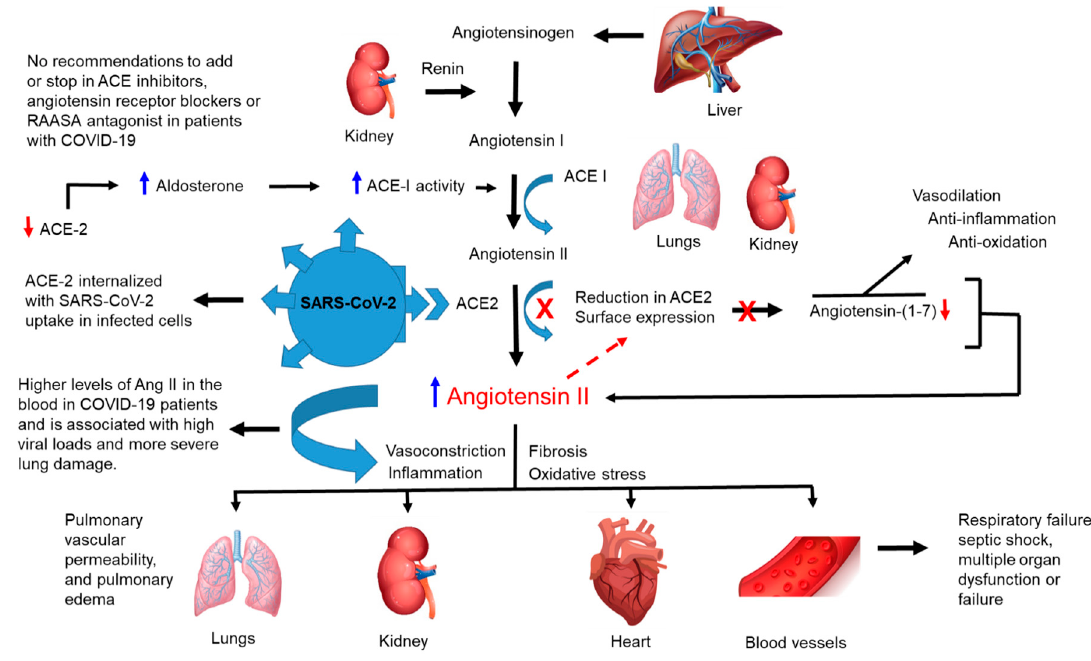
Figure 2. Hypertension and increased risk for severe COVID-19 disease. Hypothetical model of uncontrolled blood pressure in patients with hypertension and increased risk for complications due to COVID-19. The liver produces angiotensinogen, a peptide hormone that causes vasoconstriction that increases blood pressure. Angiotensinogen is converted to angiotensin I by renin from the kidneys then is converted to angiotensin II by the action of ACE (ACE-I). Normally angiotensin II (Ang. II) is converted to angiotensin-1–7 by the monocarboxypetidase ACEI homology ACE2. However, upon infection with SARS-CoV-2 the ACE2 protein serves as the entry receptor for the virus and is internalized in the endosome with SARS-CoV-2 during membrane fusion and uptake by infected cells. This leads to significant reduction in ACE2 surface expression and concomitant increase in angiotensin II, further leading to vasoconstriction that impacts blood pressure, inflammation, fibrosis, and oxidative stress in infected cells and tissues in multiple organs. Even more, the downregulation of ACE2 leads to the upregulation of aldosterone, a steroid hormone produced by the zona glomerulosa of the adrenal cortex, which increases the activity of ACE1. This action leads to higher levels of angiotensin II and an overall suppression of angiotensin-1–7, which is designed to mitigate the e ff ects of angiotensin II via vasodilation, anti-inflammatory e ff ects, and anti-oxidation. These levels of angiotensin II may result in MOD or failure. RAASA (renin-angiotensin-aldosterone system antagonist). ACE I (Angiotensin-converting enzyme